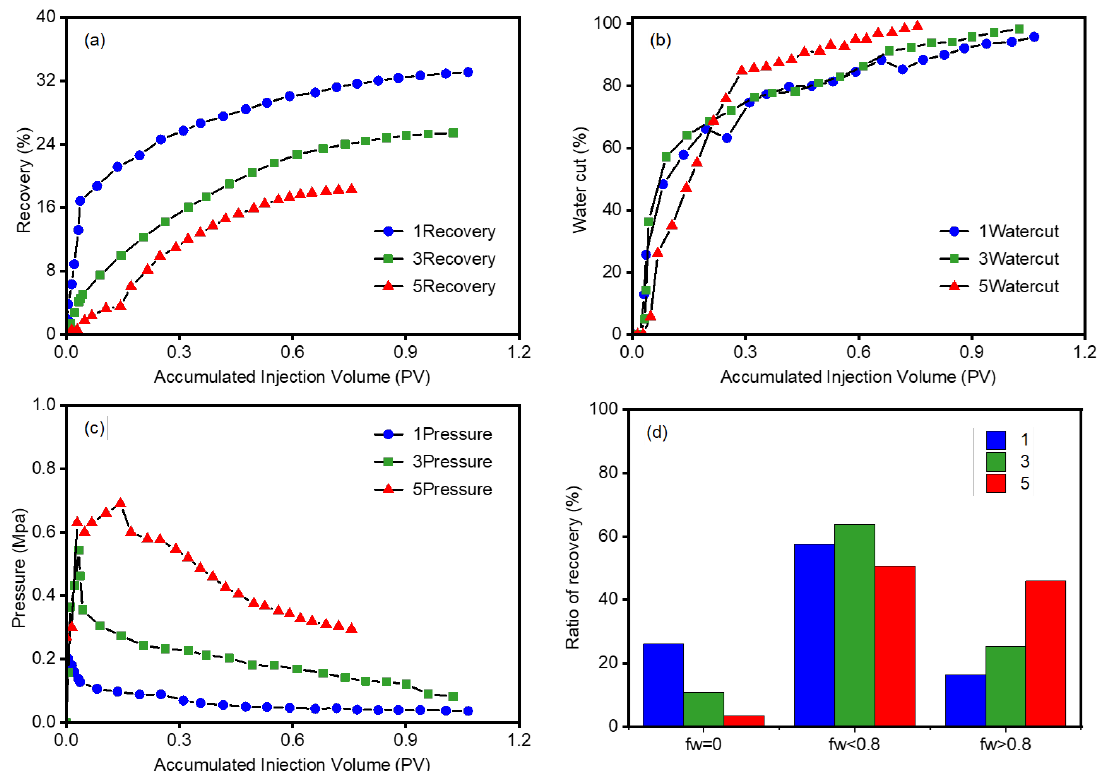
Figure 3. Recovery, water cut and pressure curves at different injection velocities. ( a ) Recovery, ( b ) water cut, ( c ) pressure, ( d ) ratio of recovery. ( b ) water cut, ( c ) pressure, ( d ) ratio of